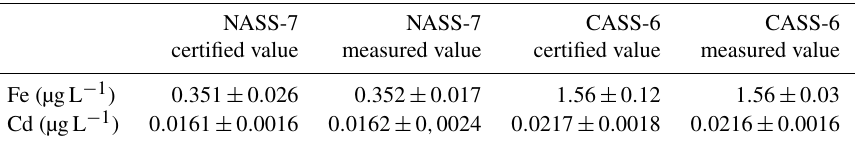
Table 1. Accuracy of replicate concentration measurements ( n = 7) of certified reference seawater for trace metals NASS-7 and CASS-6 by inductively coupled plasma mass spectrometry